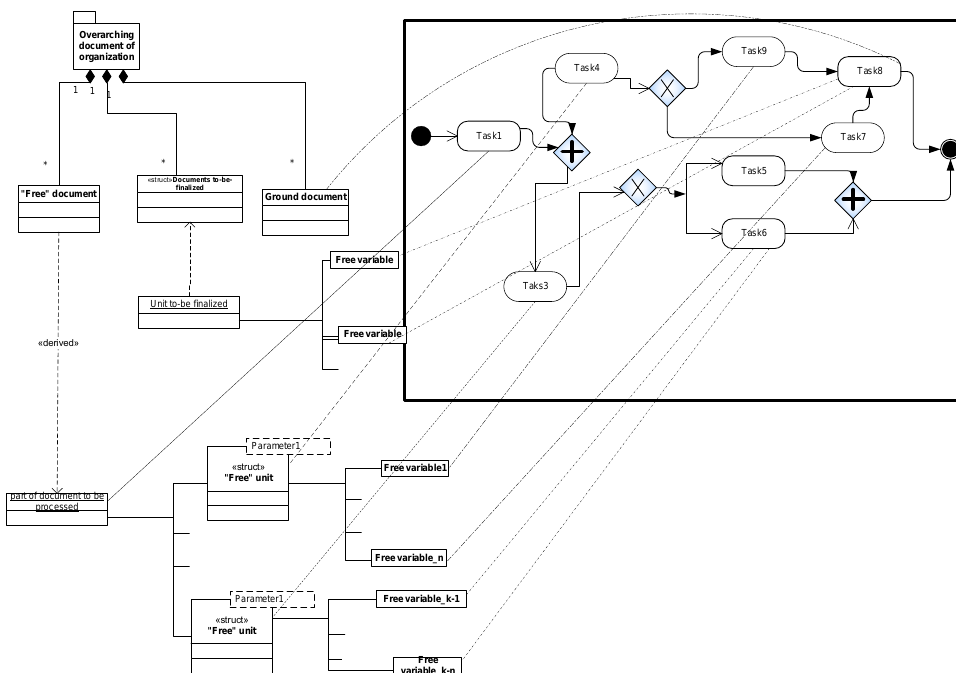
Figure 14. The interrelationships between sub-documents in processing and tasks.